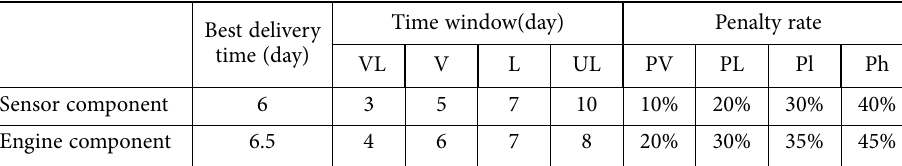
Table 5. Lead time, time window and penalty rate